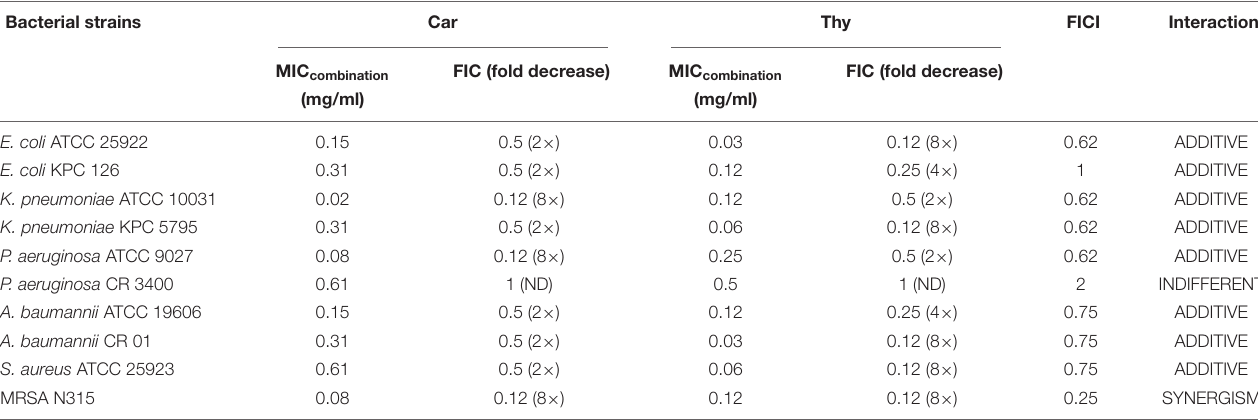
TABLE 5 | Effect of carvacrol (Car) combined with thymol (Thy) against five bacterial species, including reference and multidrug-resistant strains. Bacterial strains Car Thy FICI Interaction MIC combination FIC (fold decrease)